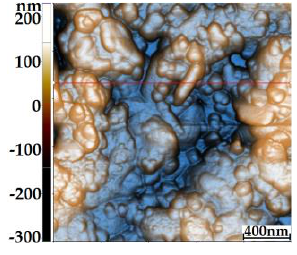
Figure 1. AFM images of the CoO sensitive films at the scale of (8 × 8) µm 2 —( a ) and (2 × 2) µm 2 —( b ) and, respectively, of the CuO sensitive films at (8 × 8) µm 2 —( c ) and (2 × 2) µm 2 —( d ).